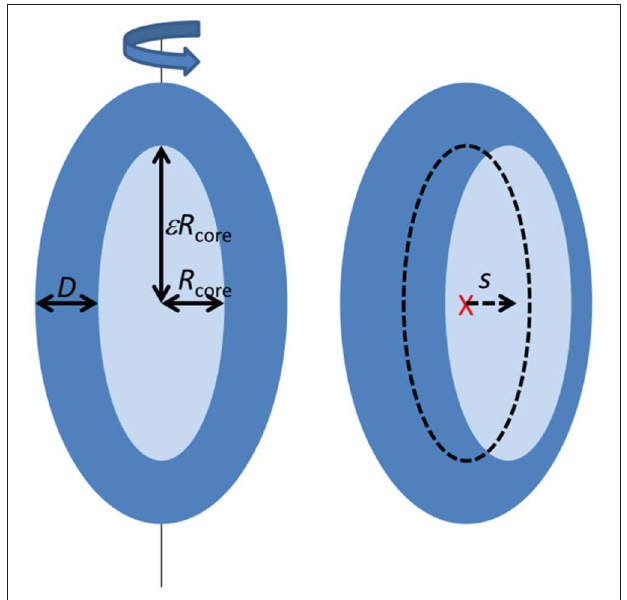
FIGURE 1 | Illustration of the structural model applied to fit the SAXS data (see